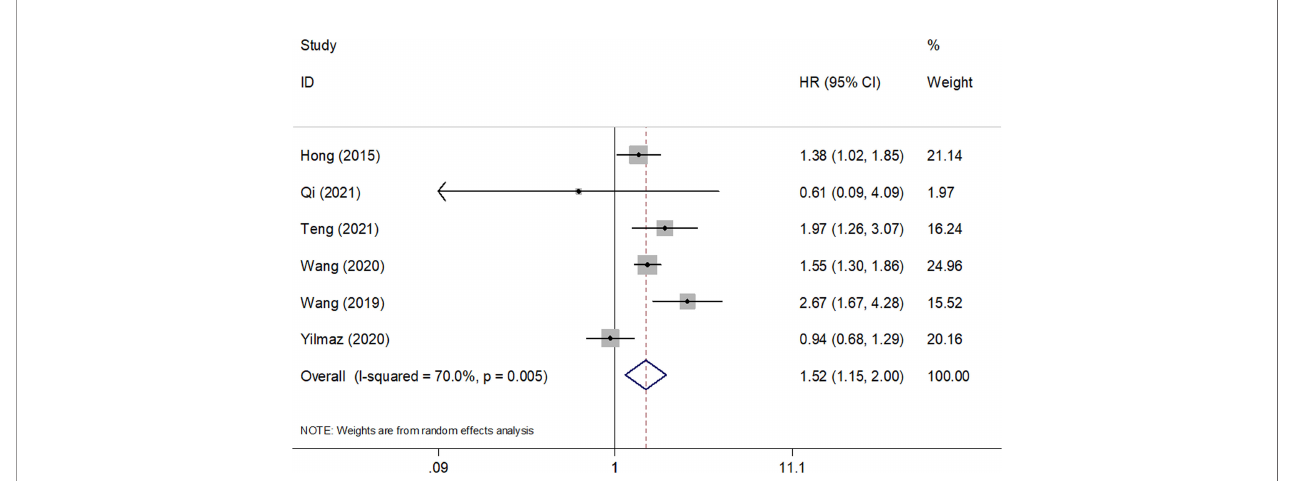
FIGURE 2 | Forest plots of pooled HRs and associated 95% CIs of the effect of high versus low SII for overall survival in patients with SCLC.